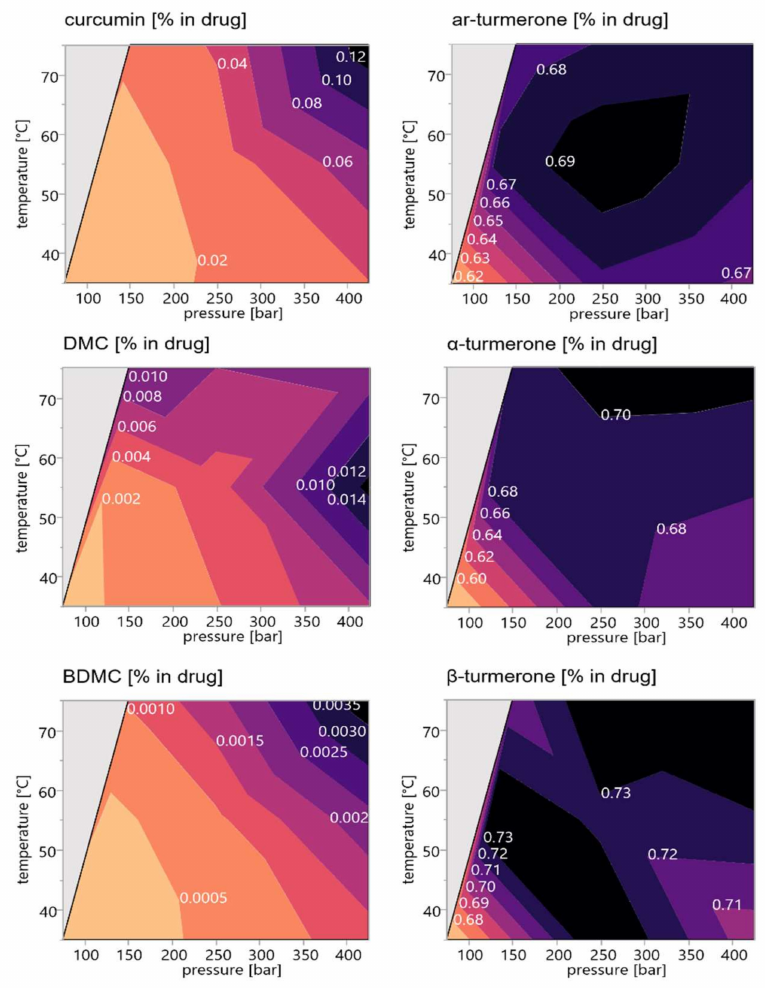
Figure 4. Response contour plots illustrating the recovery rates of all target compounds (curcumin, demethoxycurcumin (DMC), bisdemethoxycurcumin (BDMC), ar-turmerone, α -turmerone, and β - turmerone) depending on pressure and temperature; the areas marked in grey represent combinations of pressure and temperature settings, which were not investigated; recovery rates are related to the drug material in % ( m / m